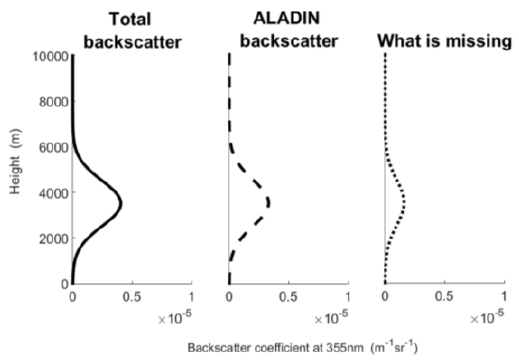
Figure 1: Total backscatter coefficient of dust at 355 nm as a function of altitude (left), the corresponding co-polar component detected by ALADIN (middle) and the undetected-missing cross-polar component